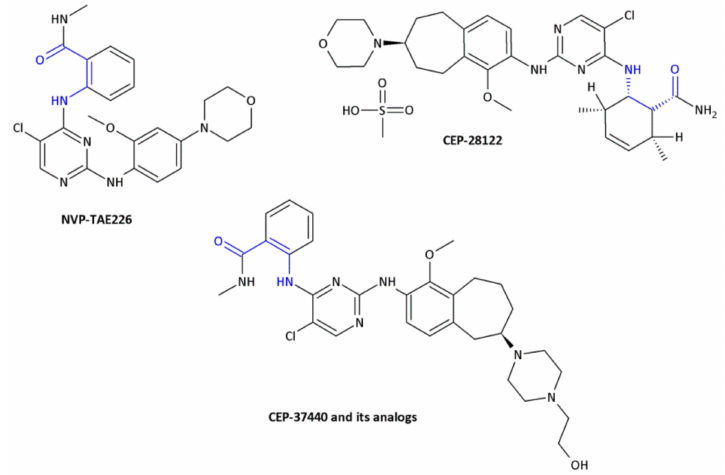
Figure 4. The structures of NVP-TAE226, CEP-28122 and CEP-37440 and its analogs that are ALK inhibitors [69].